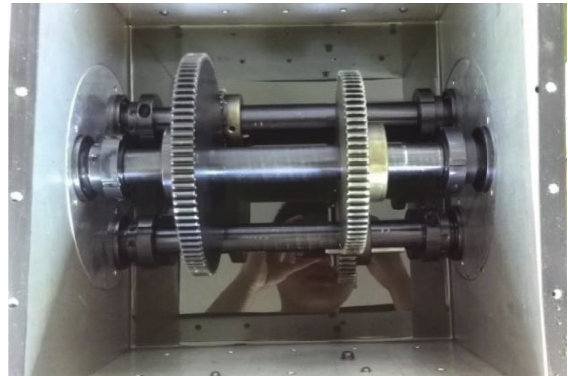
Figure 15: Internal structure of the gearbox.